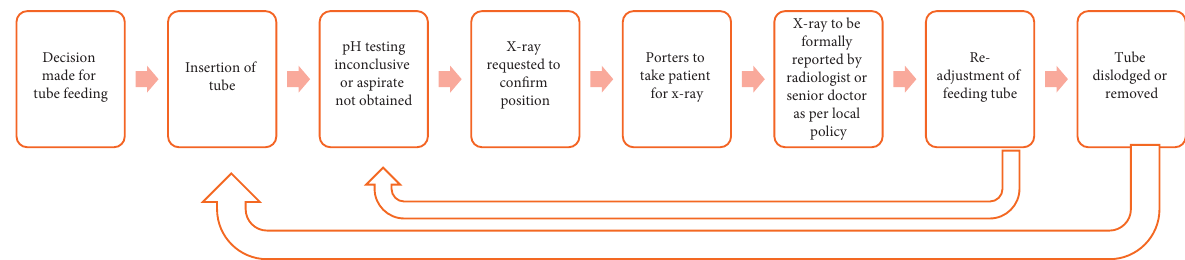
Figure 1: Schematic representing multistep process of feeding tube placement confirmation that leads to delays. Table 1: Summary of the various techniques that have been explored ( ✔ pros, ✖ cons). Novel strategies to enable “real-time” confirmation of nasogastric placement